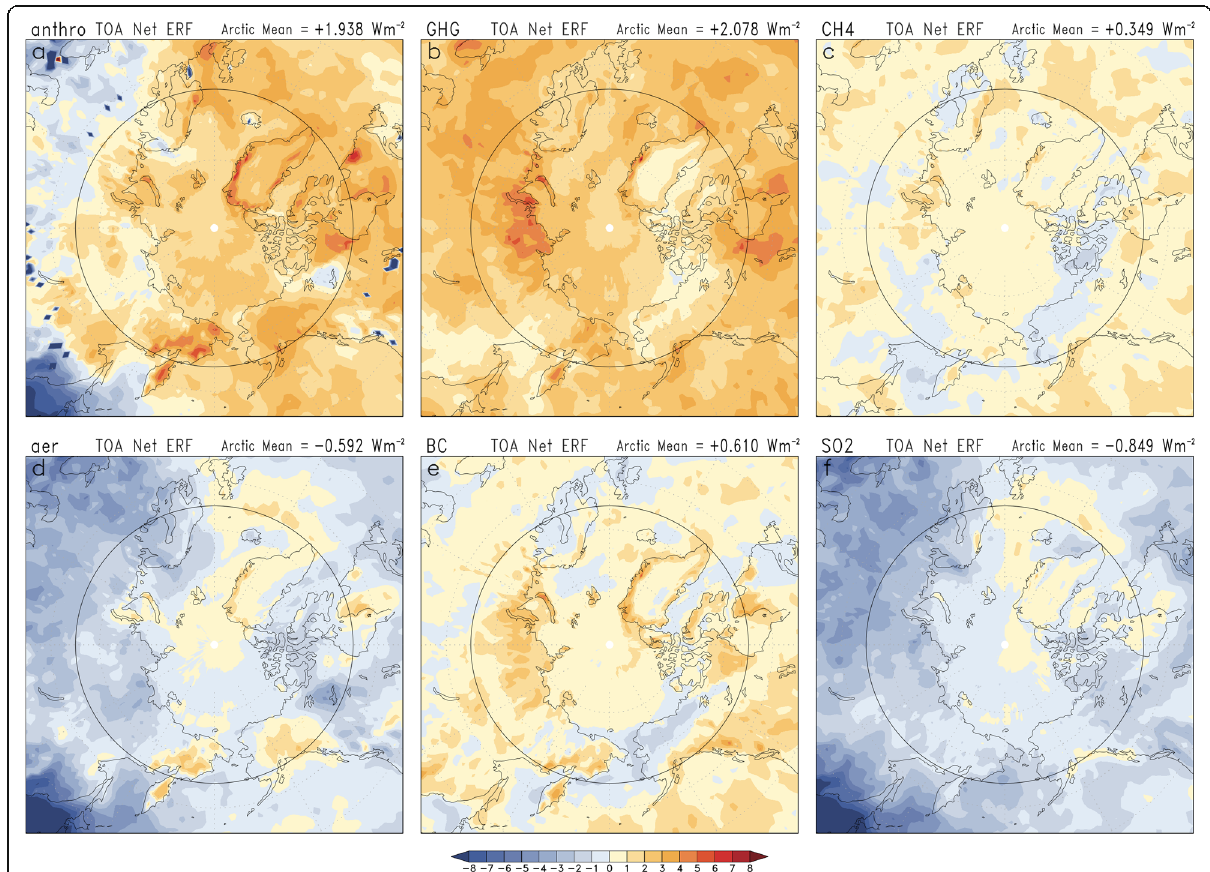
Fig. 9 Horizontal distributions of the annual mean net (net, shortwave + longwave) ERFs (W m − 2 , filled contours) at the TOA in the ( a ) piClim- anthro, ( b ) piClim-ghg, ( c ) piClim-CH4, ( d ) piClim-aer, ( e ) piClim-BC, and ( f ) piClim-SO2 experiments in MRI-ESM2.0. The ERF values averaged over the Arctic region (60 – 90°N) are shown near the upper-right corner of each panel and are given in Table 3. The black circles denote a latitude of